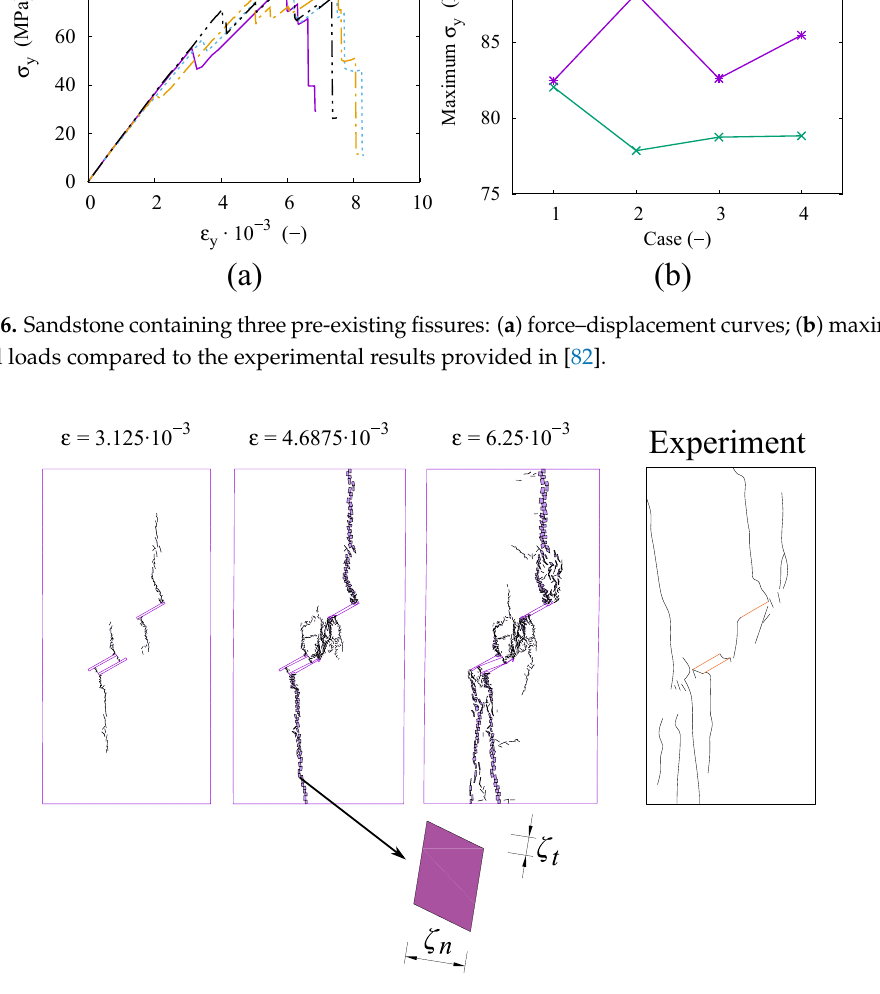
Figure 7. Sandstone containing three pre-existing fissures (Case 1): the crack opening plots (deformation scale 1:1) compared to the experimental results provided in [82].